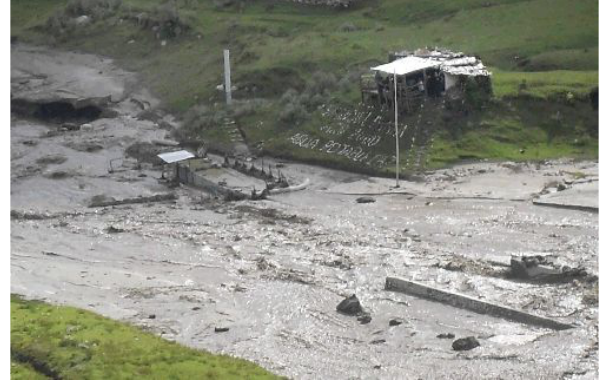
Fig. 3. Hyperconcentrated flow of 11 April 2010 at the site of the freshwater intake at Pampa Shonquil (3600ma.s.l.). The structures have been completely inundated and partially damaged (mainly through erosion and deposition of material). Photo by Arq. Luis Meza,